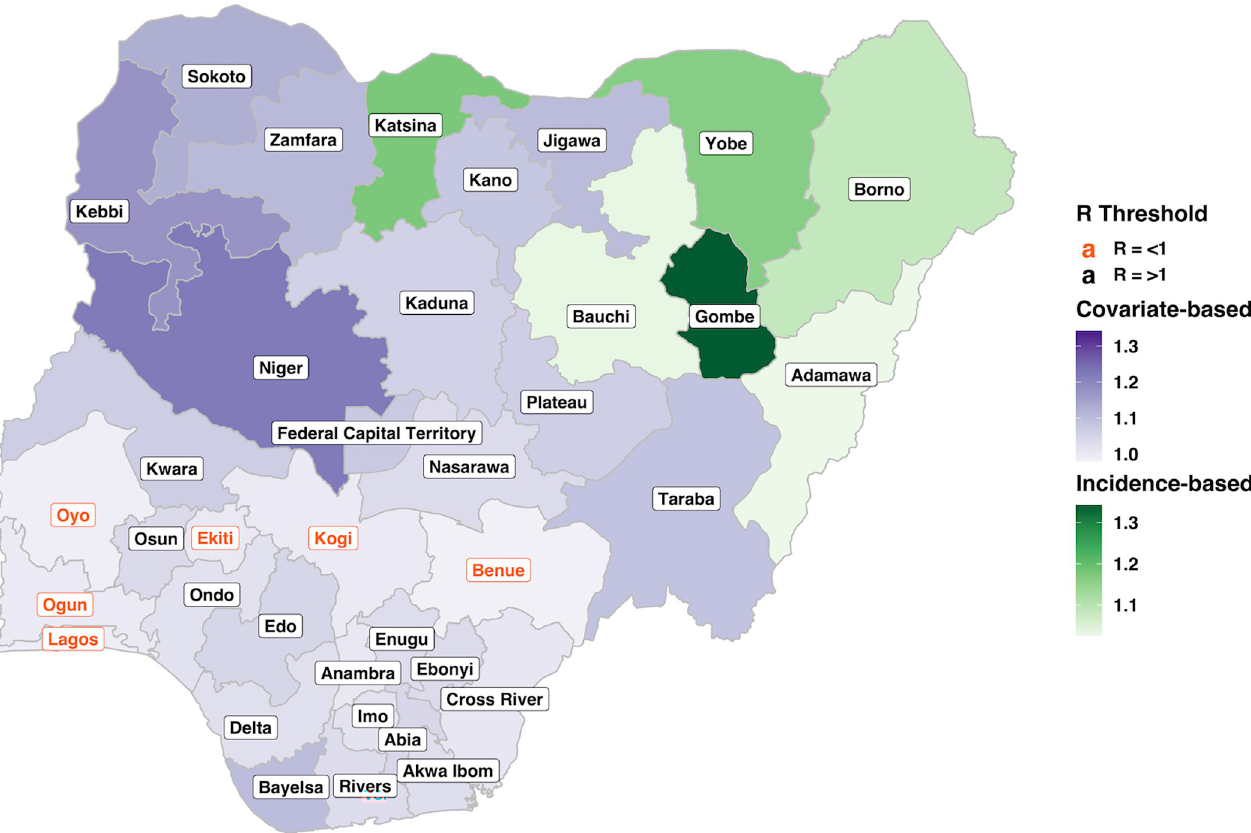
Fig 6. Average R values for 2018 and 2019 for all 37 Nigerian states. Incidence-based (green)—the six states which met the equal to or more than 40 case thresholds. Covariate-based (purple)—the 31 states which did not meet the threshold and had R predicted using the best fit model. State label colour shows which states had an average R of R = > 1 (black) and R = < 1 (orange) [44].